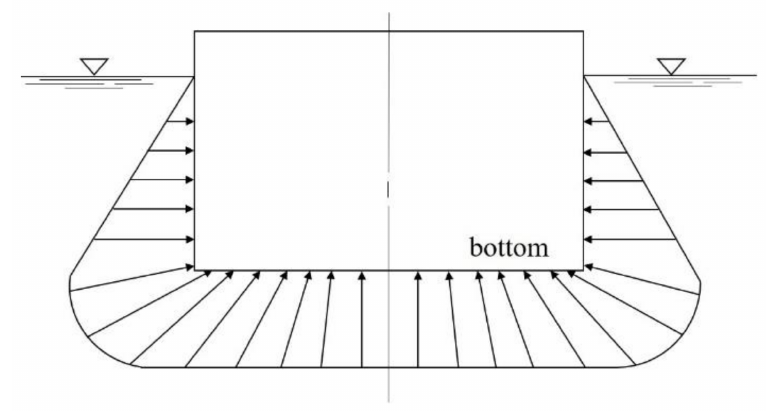
Figure 1. The configuration of hull